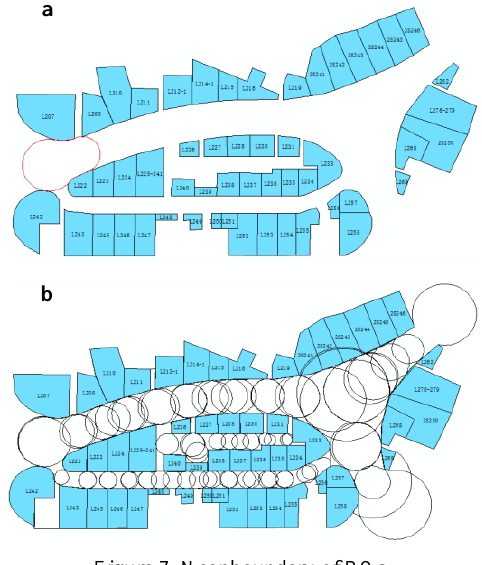
Figure 6. Wi-Fi number distribution of RPs. Figure 7. The red line region in figure 7 a is the near boundary of L207. Figure 7 b shows all the near boundary of the ROs.